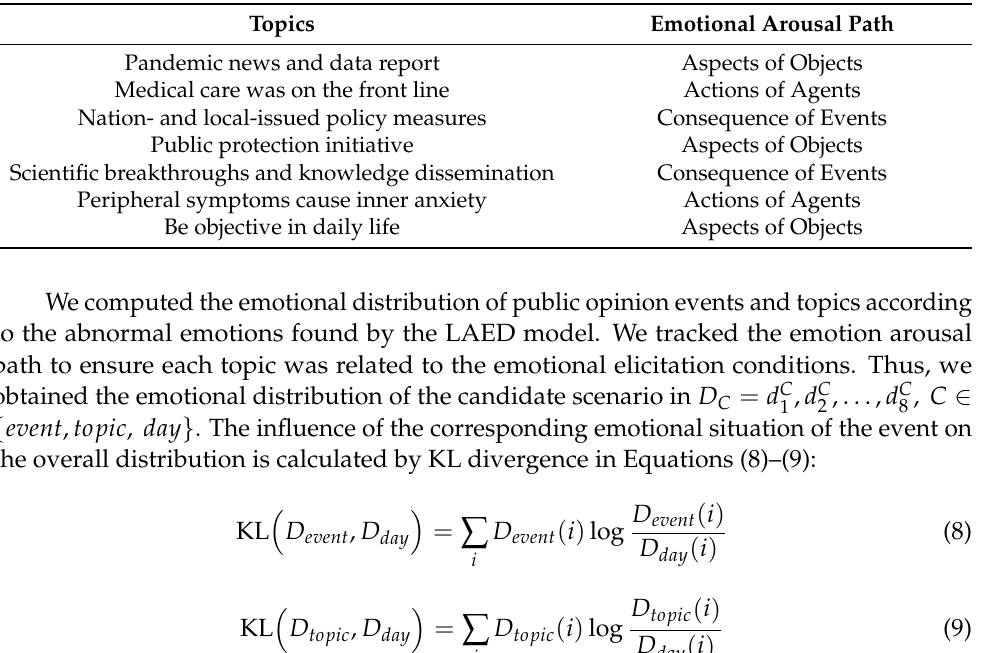
Figure 5. Eight Discrete Emotions Corresponding to the OCC Model. Table 2. Seven Topics and Three Emotional Arousal Paths.